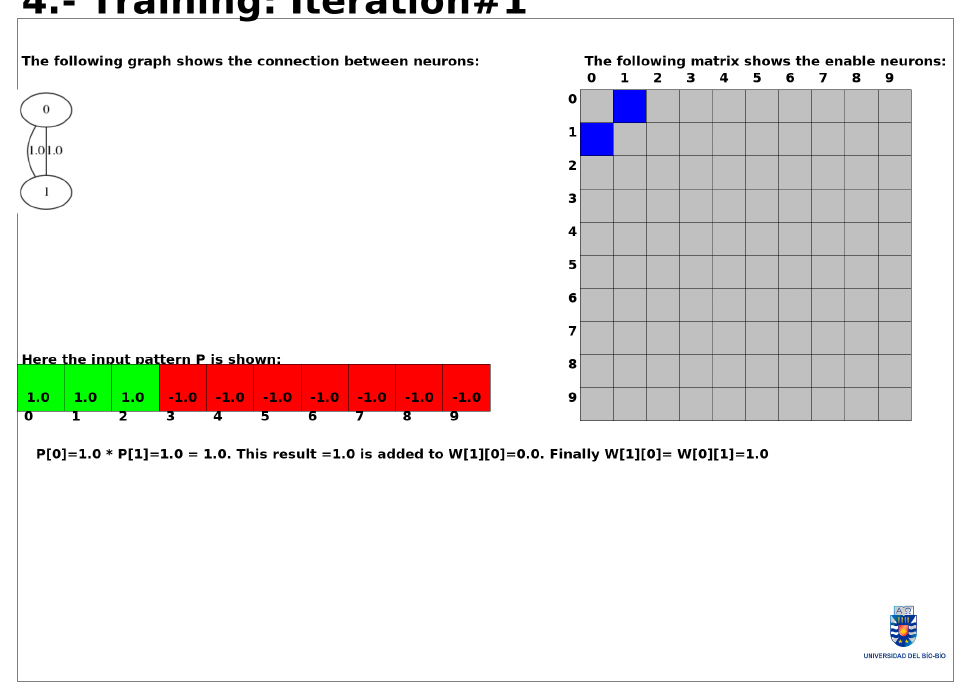
Figure 6. Frame automatically generated in which textual explanations are combined with graphical representations (first-order and